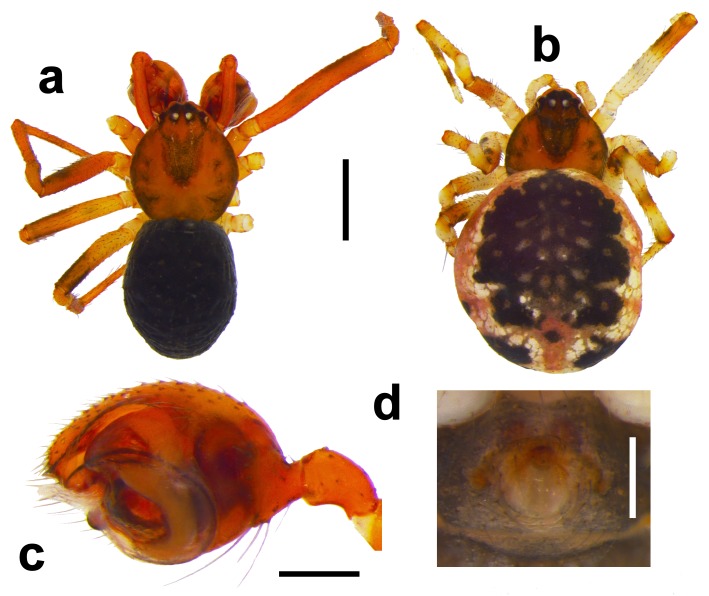
Sardinidion
blackwalli (O. Pickard-Cambridge, 1871). a: male, dorsal habitus, scale = 0.7 mm; b: female, dorsal habitus, scale = 0.7 mm; c: left male palp, retrolateral, scale = 0.2 mm; d: female epigynum, ventral, scale = 0.2 mm.